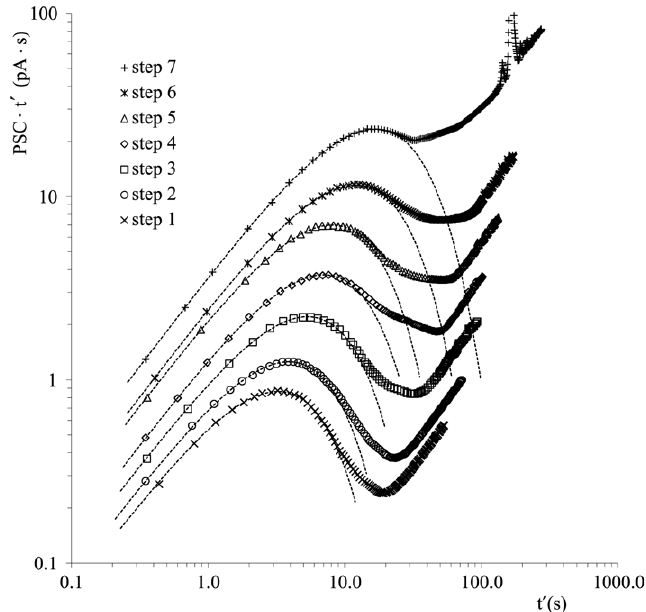
Figure 3. The seven PSC signals with respect to time t´ ([PSC( t´ )] · t´ vs t´ ). The time scale t´ = t – t , where t is the time when the PSC signal reaches 0 0 its maximum value. The dotted curves correspond the the best exponential fitting according to Equation (2) The PSC signals deviate from the which is characteristic for each stress step. exponential law after a time t e